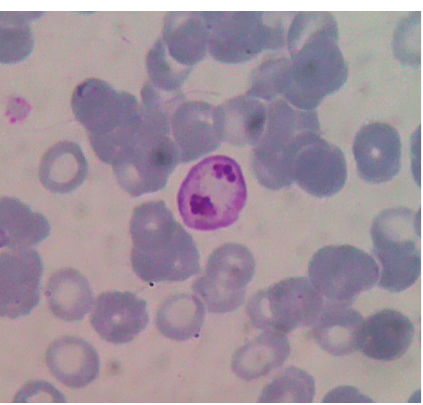
Figure 2: A peripheral blood smear of case 2 showed immature schizonts form of Plasmodium